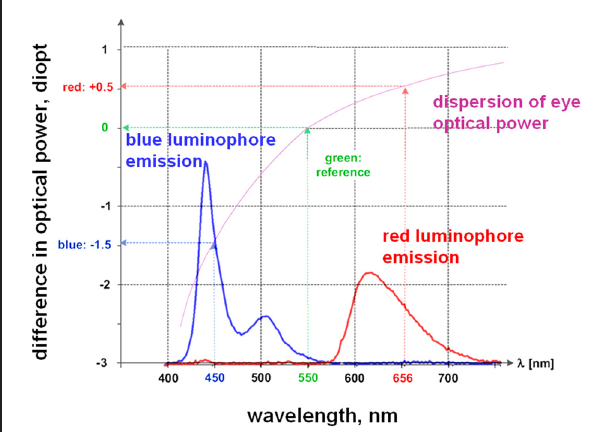
FIGURE 2 | Blue and red pixel emission spectra (used on the LED screen in the trials) together with the variation in the eye’s refractive power with emission wavelength (latter data from Gross et al.,